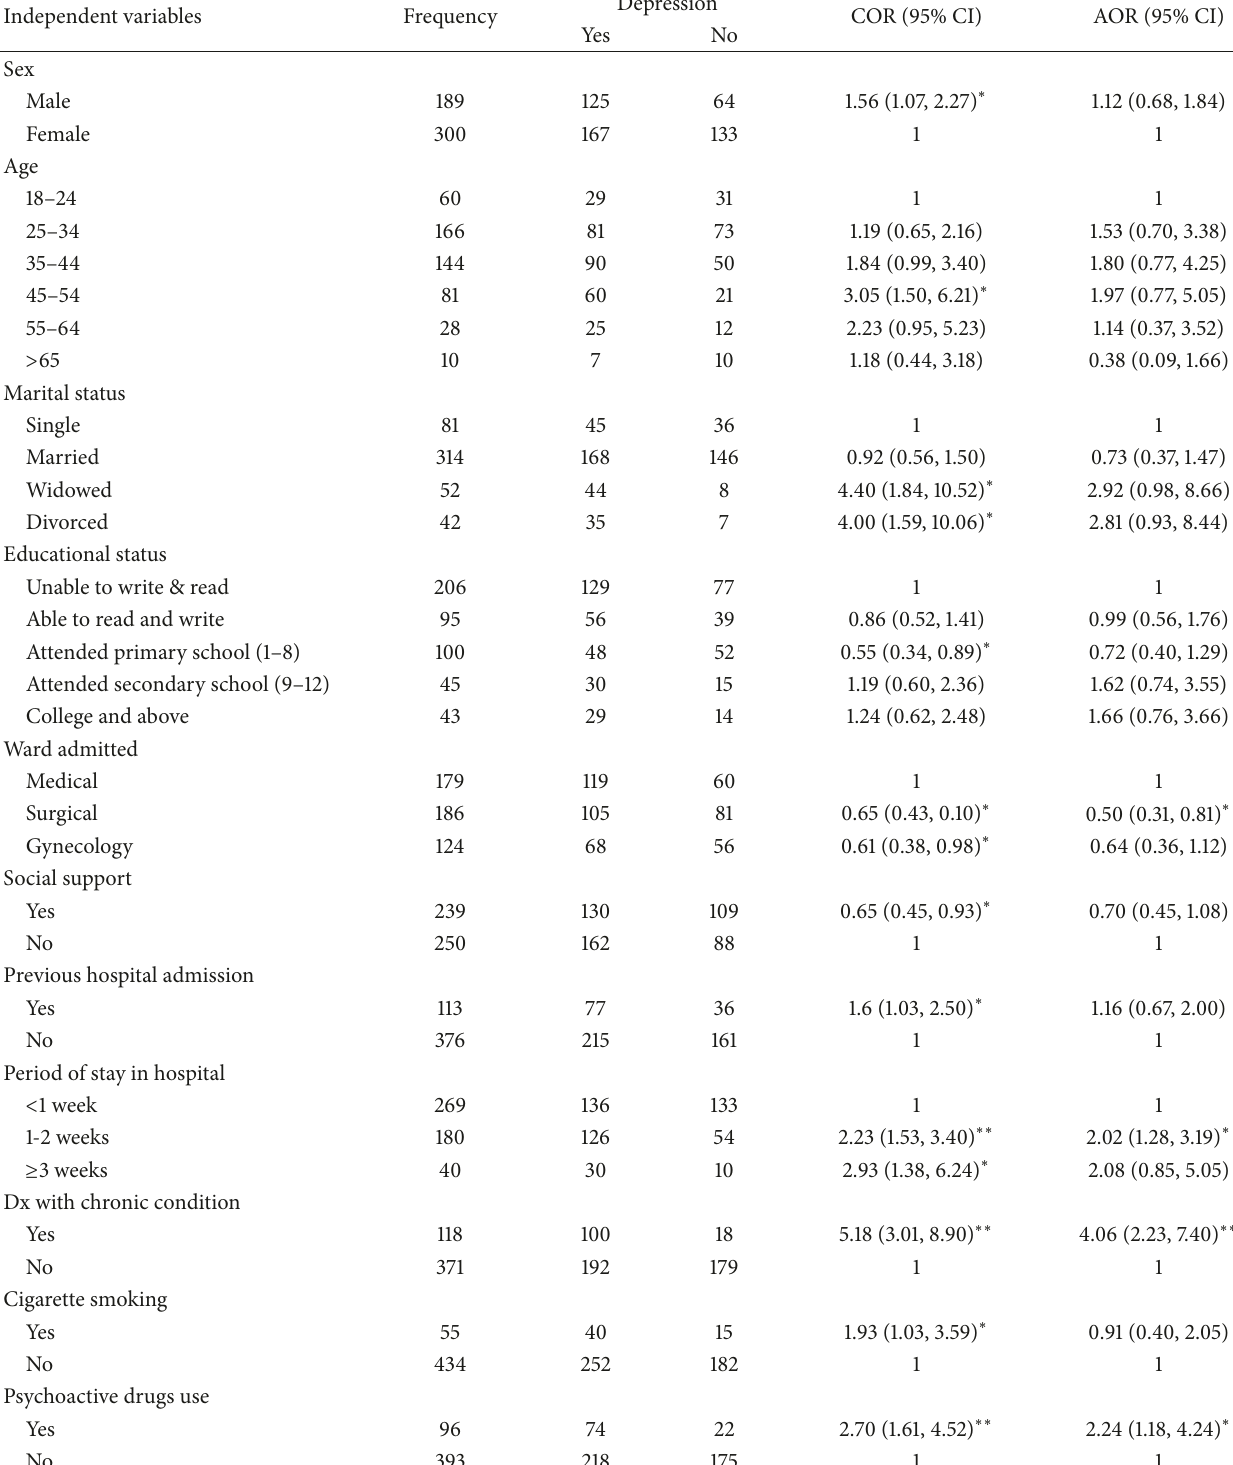
Table 4: Factors associated with depression among adult inpatients in Harari region hospitals, Eastern Ethiopia, 2017 ( 𝑛 = 489 ). Independent